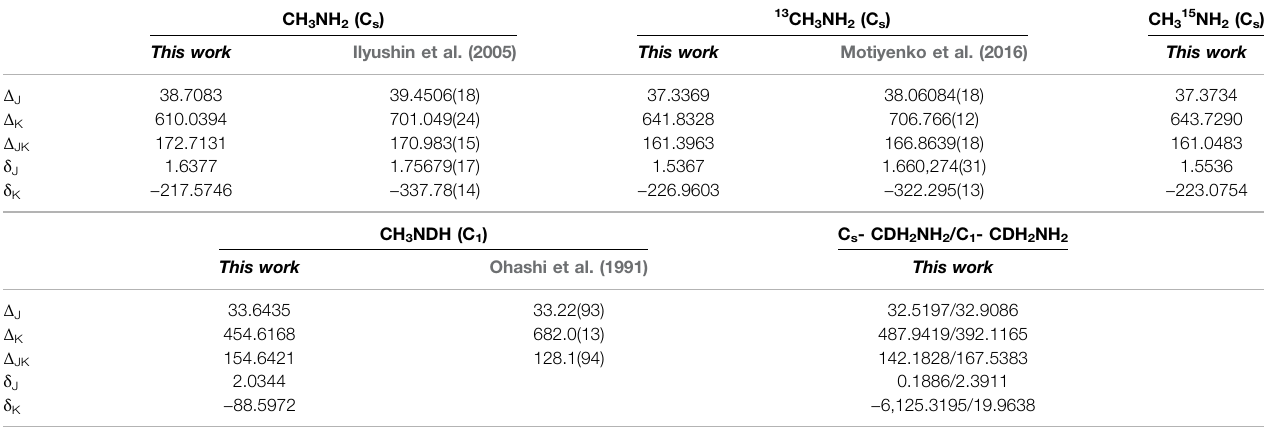
TABLE 2 | MP2/AVTZ quartic (in KHz) centrifugal distortion constants a computed using the MP2/AVTZ cubic force fi